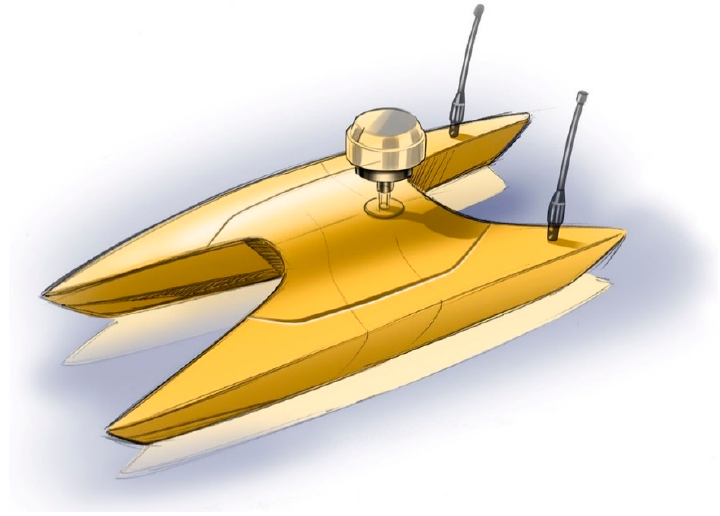
Figure 17. An industrial mock up in fiberglass.